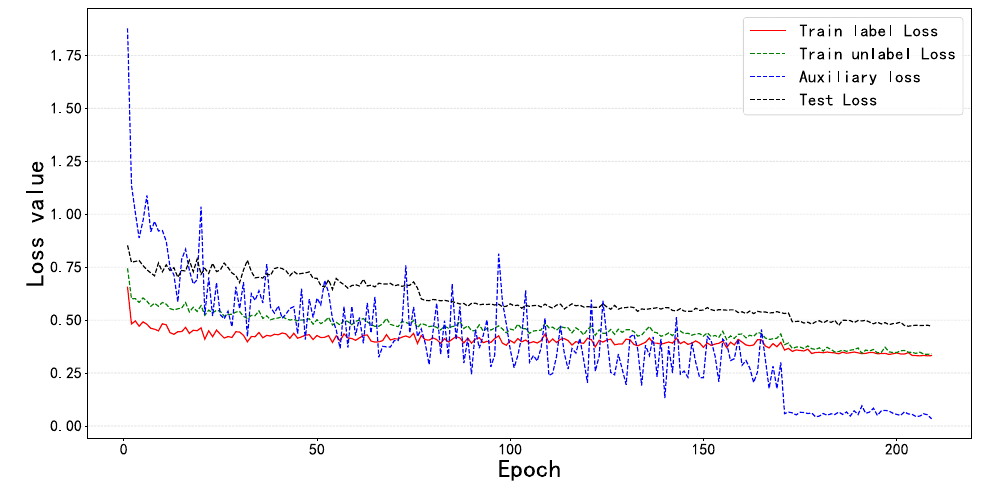
Figure 7. Variation of loss curve between training set and test set.